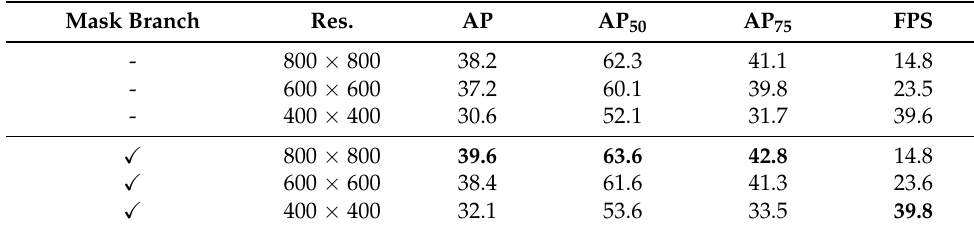
Table 8. Comparing RetinaNet with auxiliary mask branch and without mask branch for different input resolutions. Across all resolutions the auxiliary mask branch is showing a significant increase in precision while not impairing the FPS since it is not executed during inference.